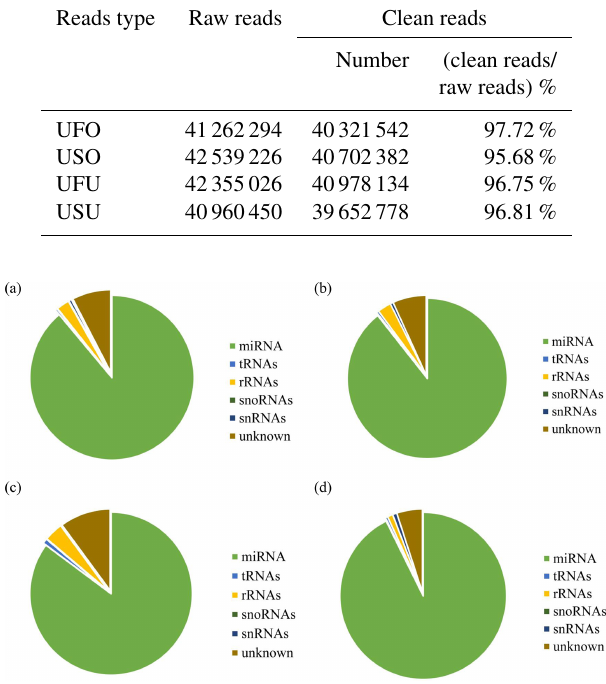
Table 1. Percentage and distribution of sequencing results in four libraries.